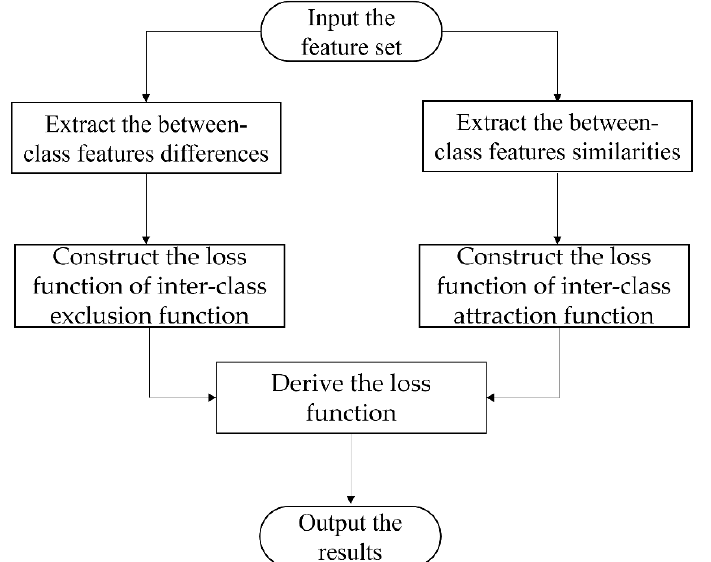
Figure 5. The steps of the cluster analysis. We use the between-class features differences to update the parameters to distinguish the multiple fish specimens and use the between-class features similarities to make the features of the same cluster move closer to the center so as to achieve the effect of clustering the features of the same species of fish.